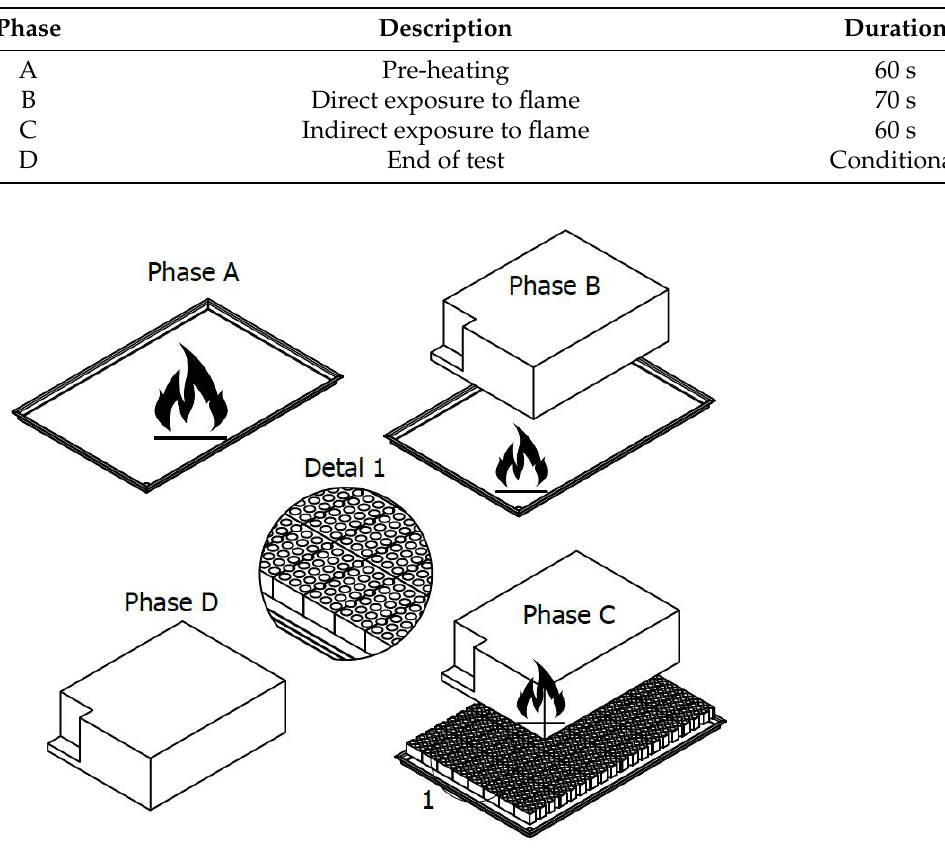
Figure 1. Testing setup and testing